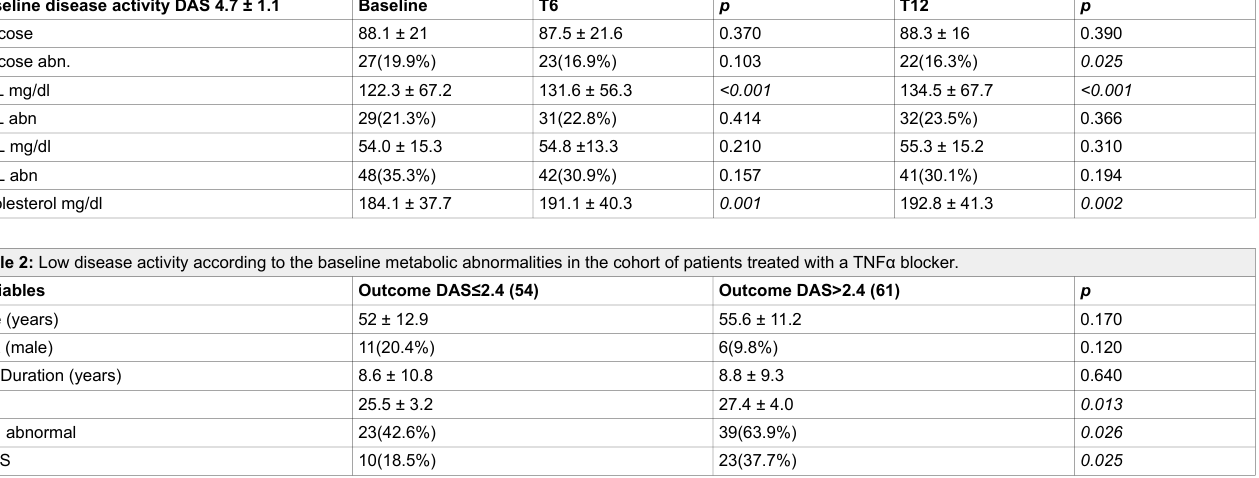
Table 1: Behaviour over time of the metabolic variables in the 115 patients treated with a TNFα blocker (Adalimumab). Baseline disease activity DAS 4.7 ± 1.1